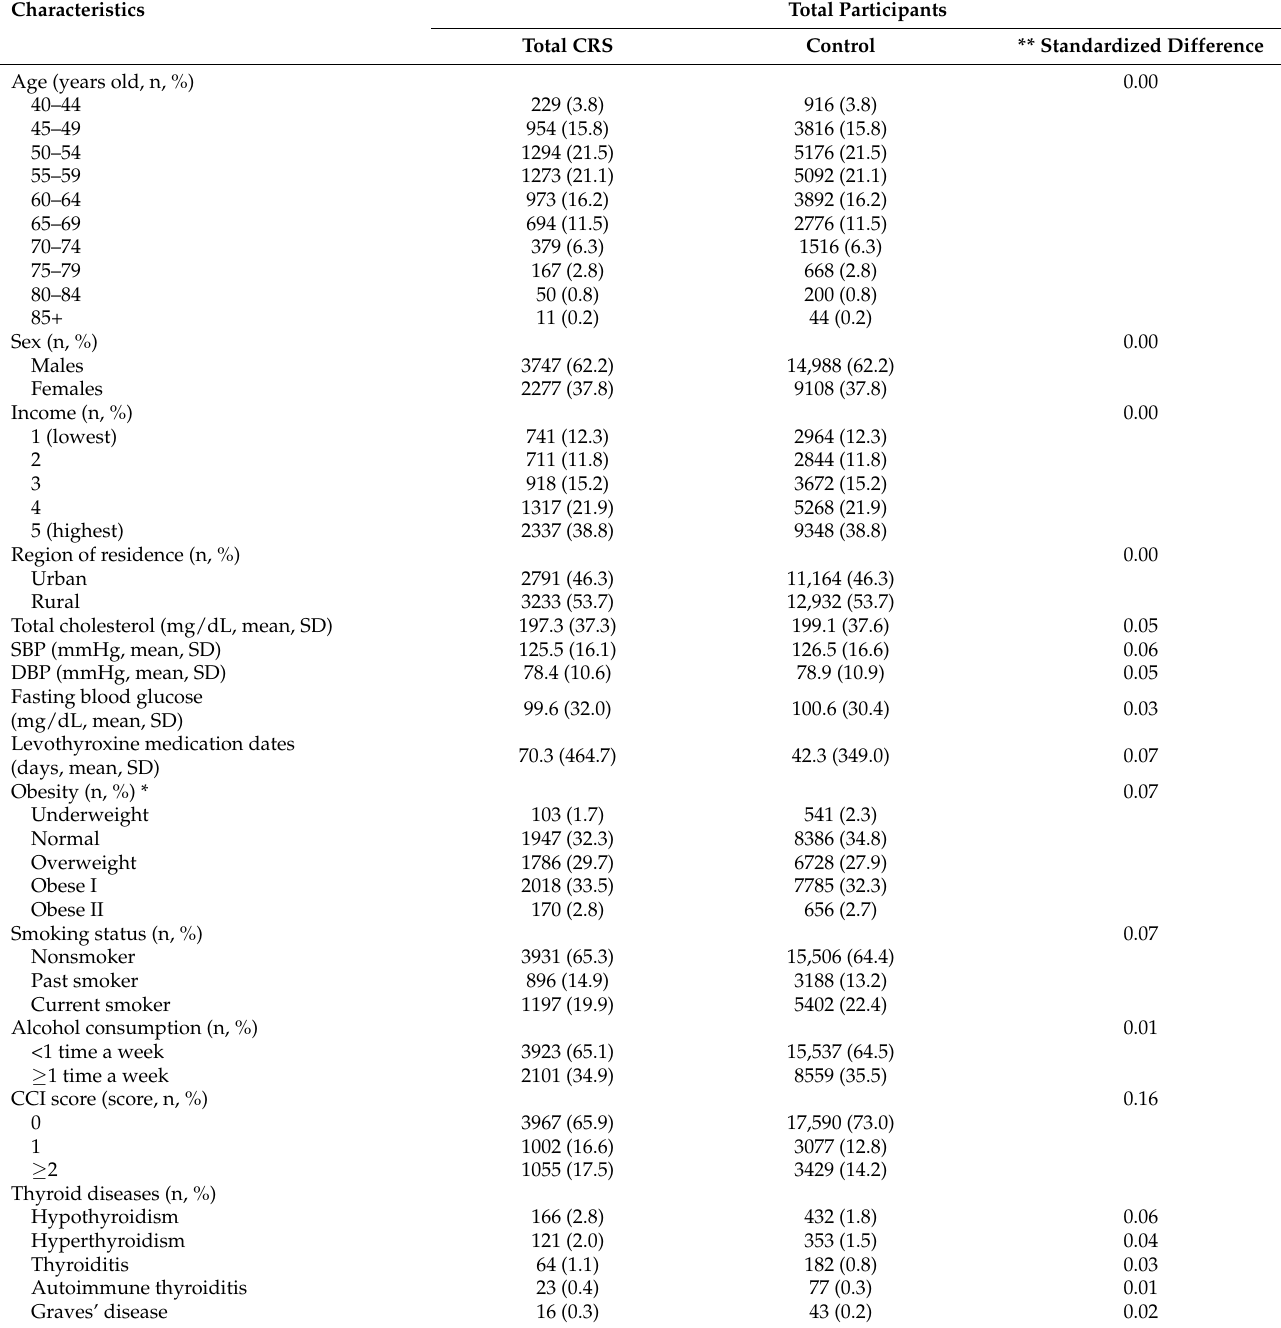
Table 1. General characteristics of